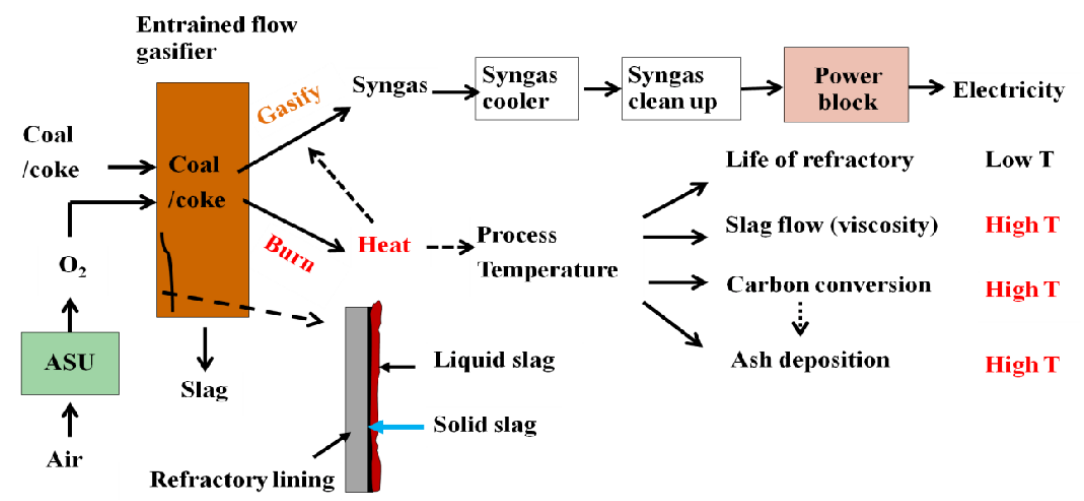
Figure 1. Function of oxygen and impact of process temperature on gasification in IGCC [9,16,20,29].